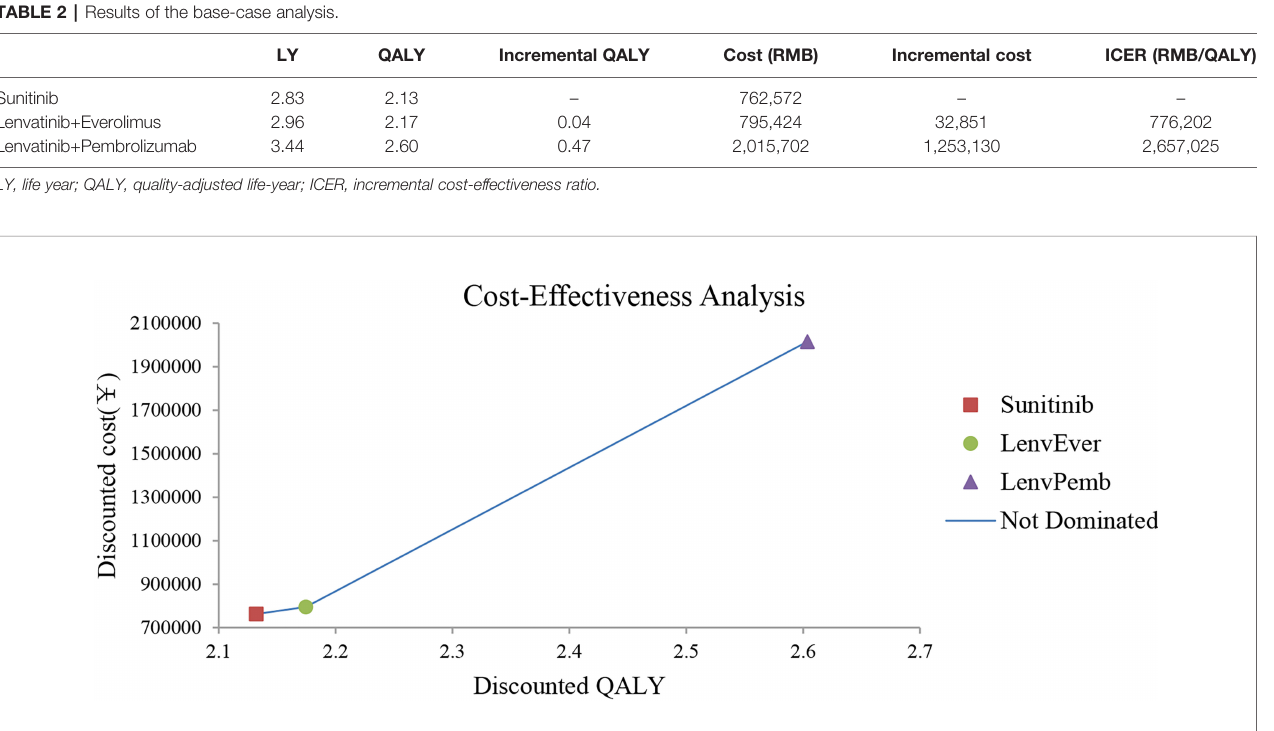
FIGURE 2 | Results of the base-case analysis in the Partitioned Survival model. LenvPemb, Lenvatinib-plus-Pembrolizumab; LenvEver,